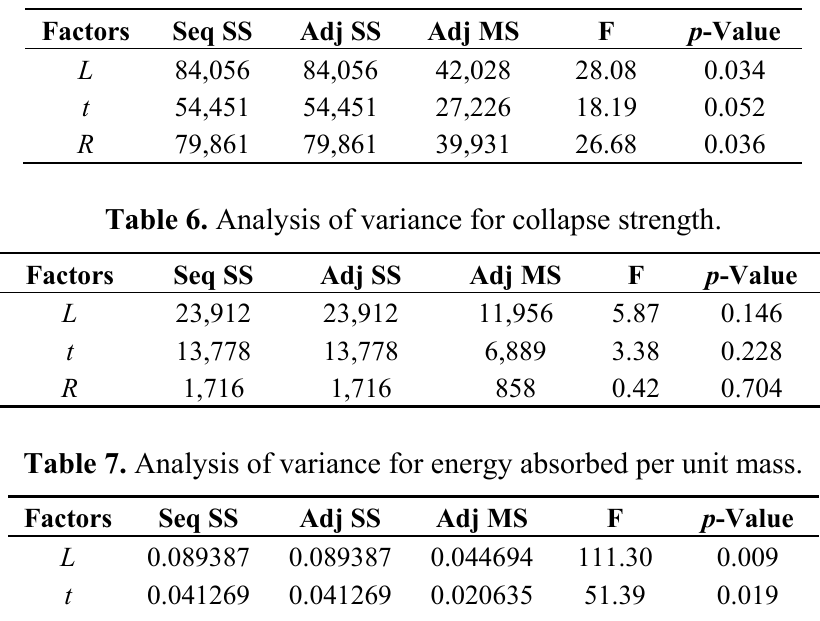
Table 5. Analysis of variance for peak strength.